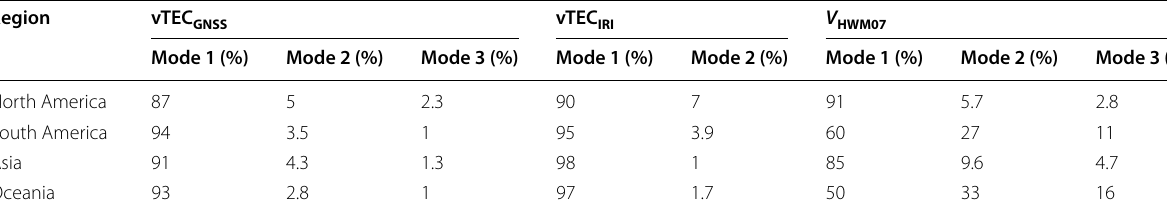
Table 2 Percentage of variability for each data set and region